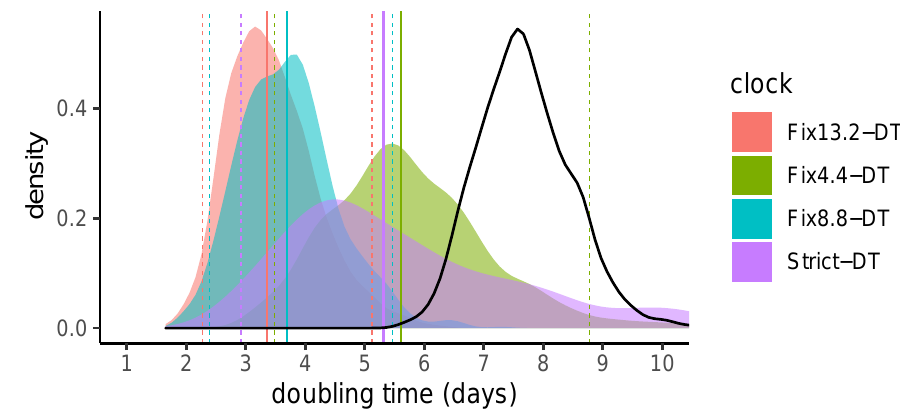
Figure S6 – Effect of the molecular clock on the doubling time. Note that in the "Strict" model we infer the value using a strict molecular clock but the width of the posterior distribution is large which indicates a lack of phylogenetic signal. The thick black line shows the prior distribution (the true prior values do not allow to see the regular plot so we use here Gamma(3,100) instead of Gamma(0.001,1000)). Here, an exponential growth coalescent model is assumed and the dataset used is